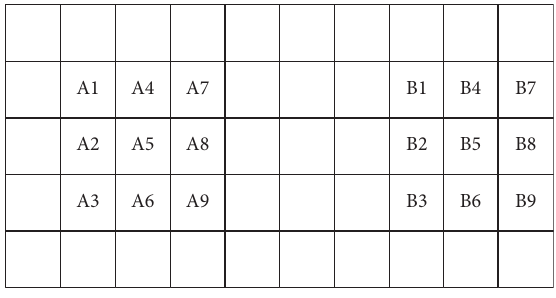
Figure 2: Schematic diagram of Climber